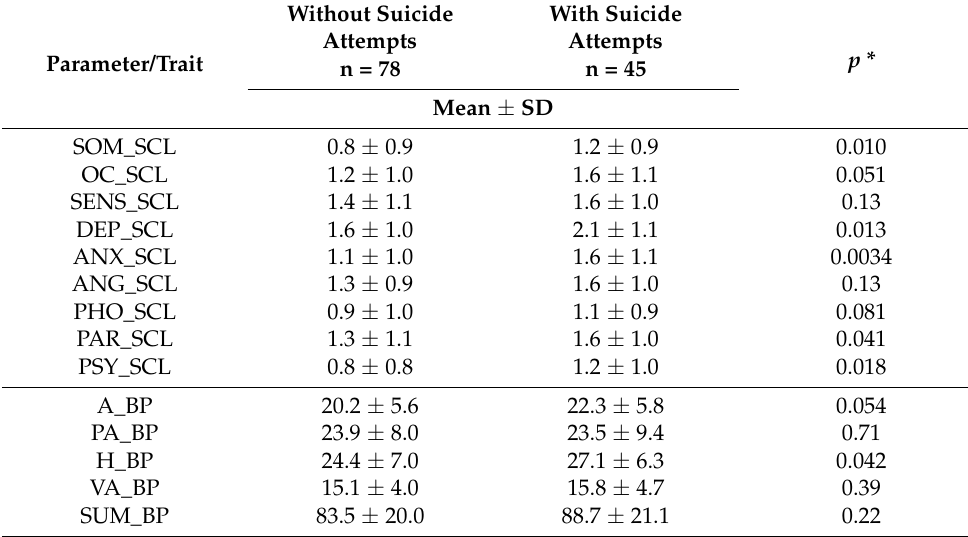
Table 2. Comparative analysis of psychological characteristics of adolescents, depending on at- tempted suicide/unattempted